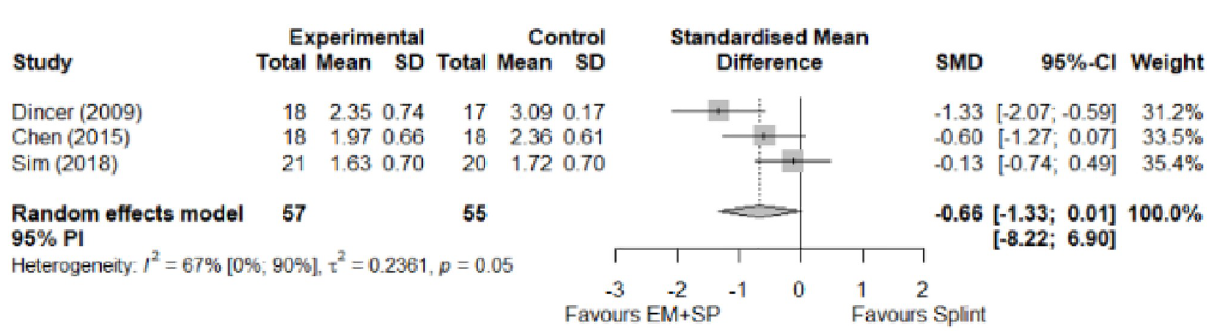
Fig 29. Analysis—Electrophysical modalities versus splinting (symptoms severity).